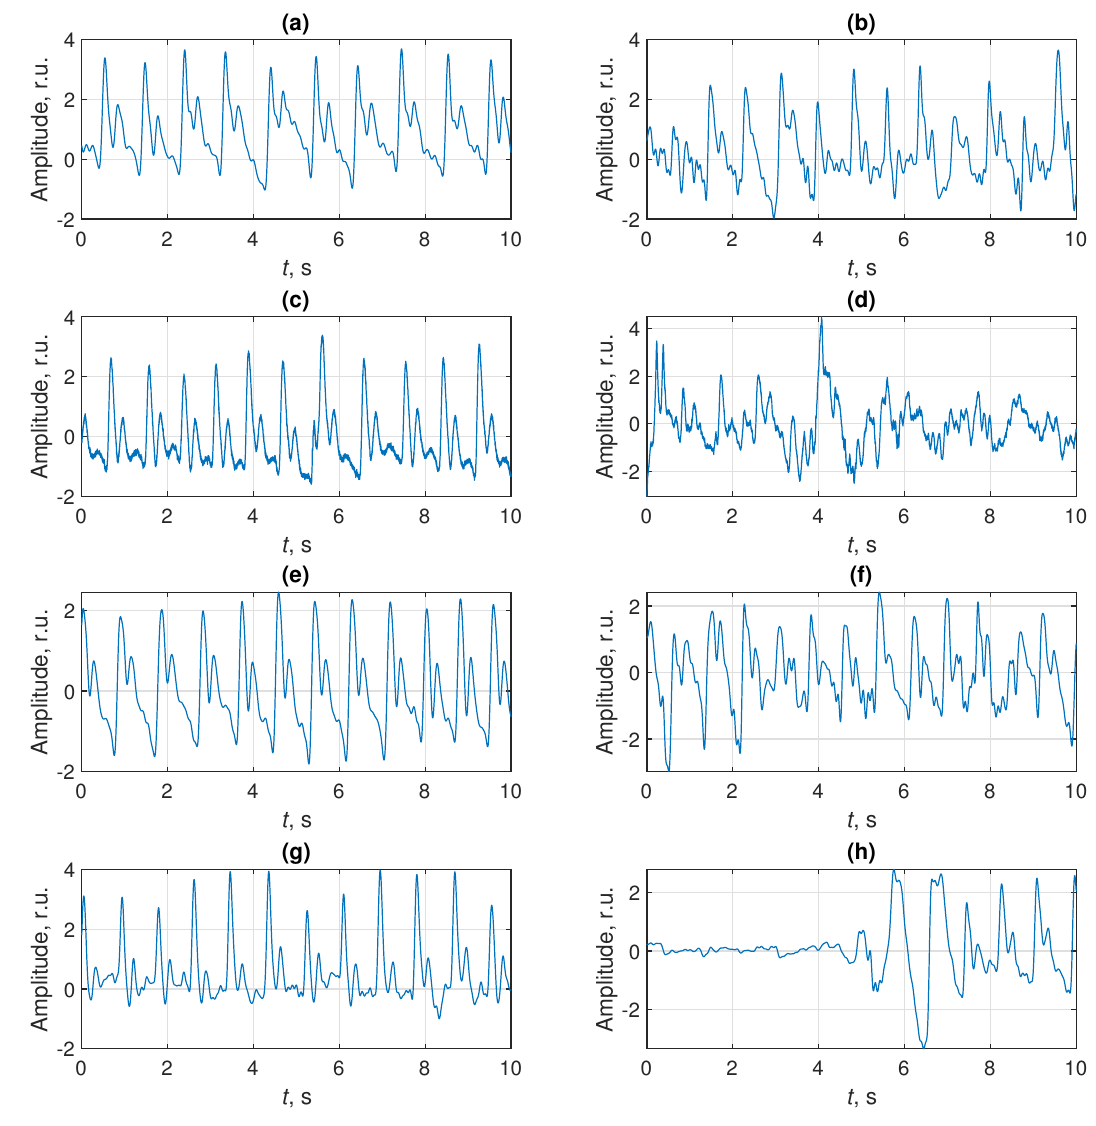
Figure 8. Examples of PW signals measured at radial artery of Subject I using FPI ( a , b ) FBG ( c , d ), OCT ( e , f ) and SMS ( g , h ) sensors in case of still posture ( a , c , e , g ) and palm movement ( b , d , f , h